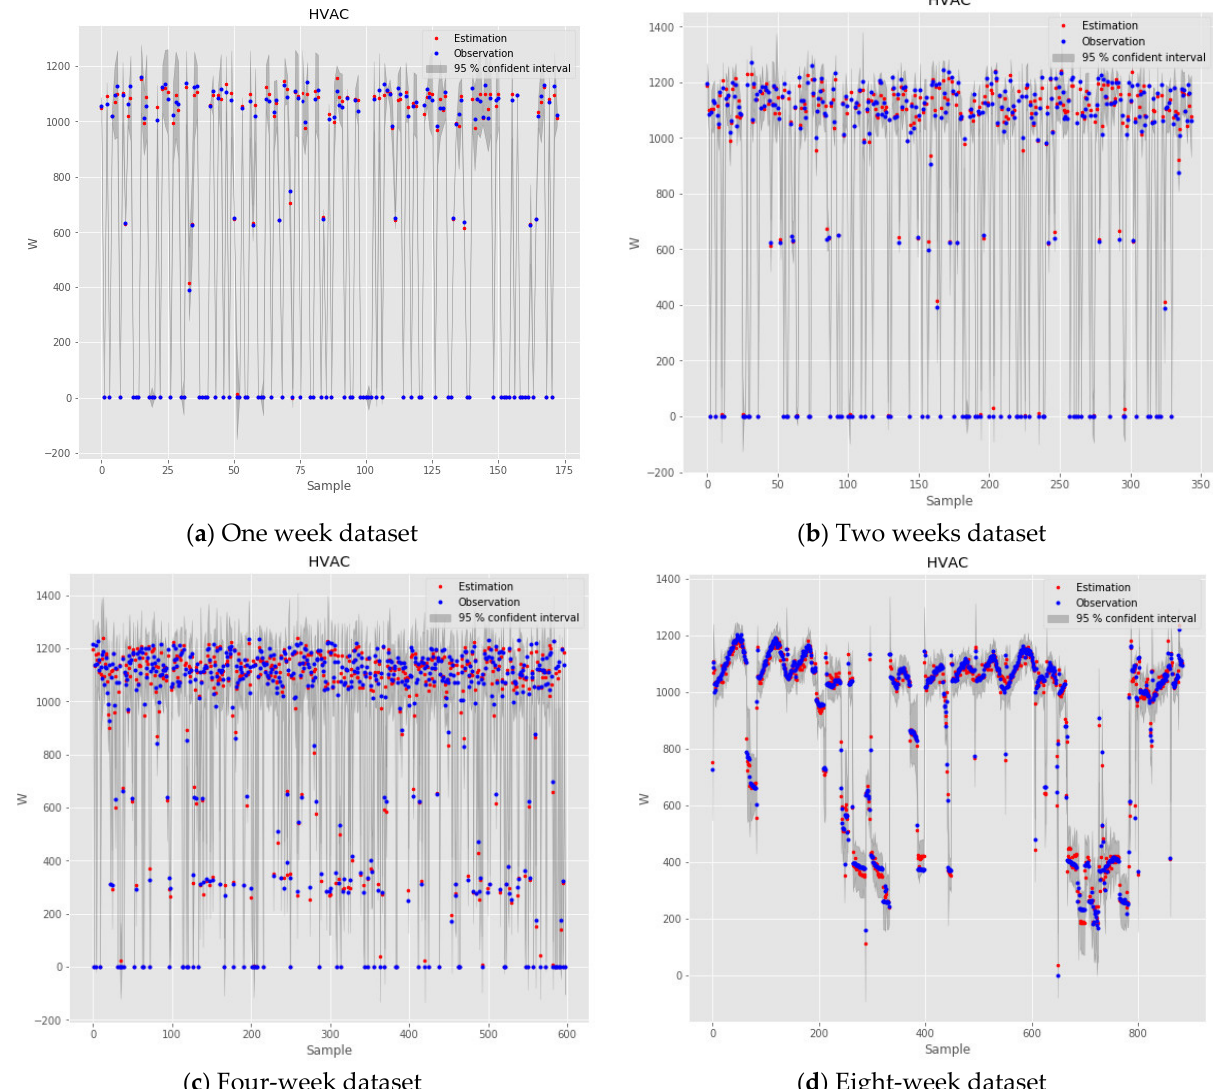
Figure 9. Estimation and observation of power HVAC in different dataset sizes.